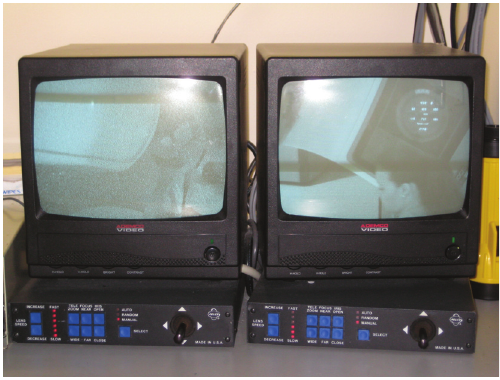
Figure 7: A remote monitor